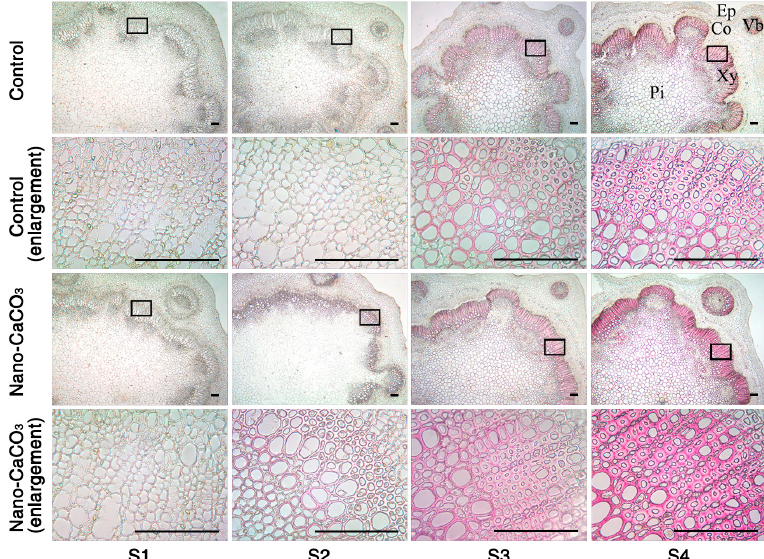
Figure 9. Histochemical staining of lignin in Paeonia lactiflora inflorescence stems subjected to Control and Nano-CaCO 3 treatment at four developmental stages. Transverse sections of 8- µ m thickness were stained with phloroglucinol-HCl, which selectively stains lignified cell walls. Sections of inflorescence stem in Control and Nano-CaCO 3 treatment. Micrographs of partial enlargement of regions are marked by the black box. Ep, epidermis; Co, cortex; Vb, vascular bundle; Pi, pith; Xy, xylem. Bars, 150 µ m. S1, flower-bud stage; S2, pigmented stage; S3, unfold-petal stage; and S4, full-flowering